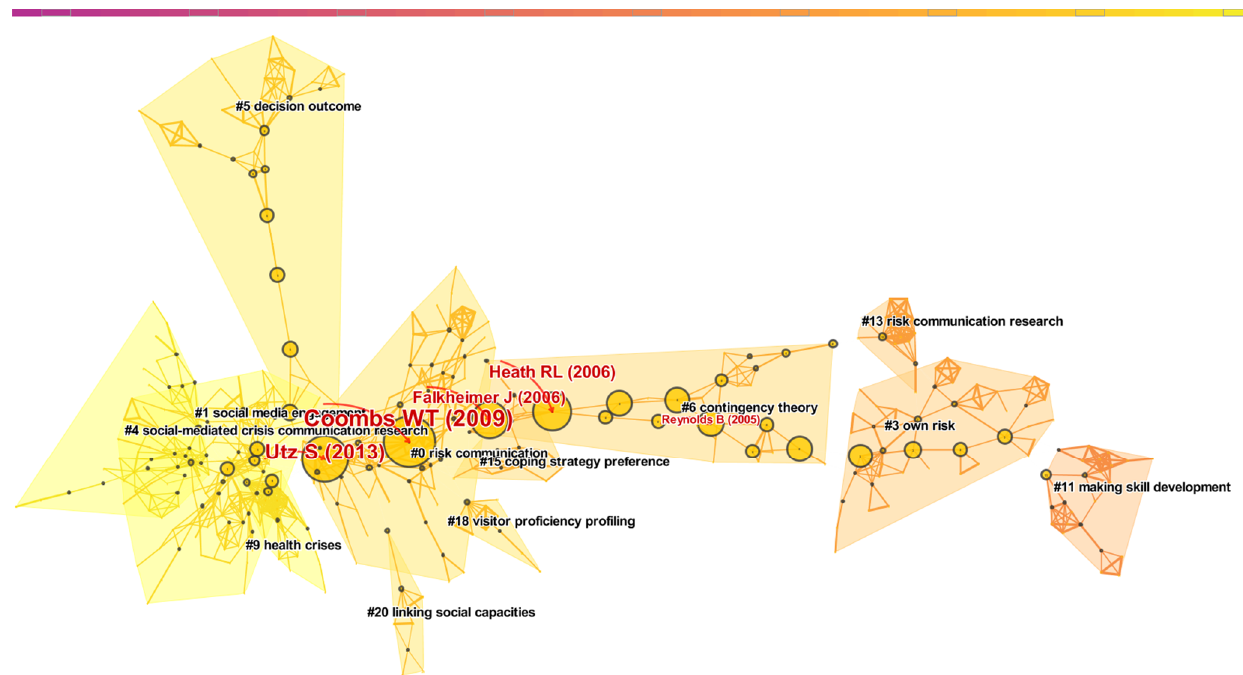
Figure 9. Map of the literature co-citation network of crisis and risk communication research. Cluster Analysis